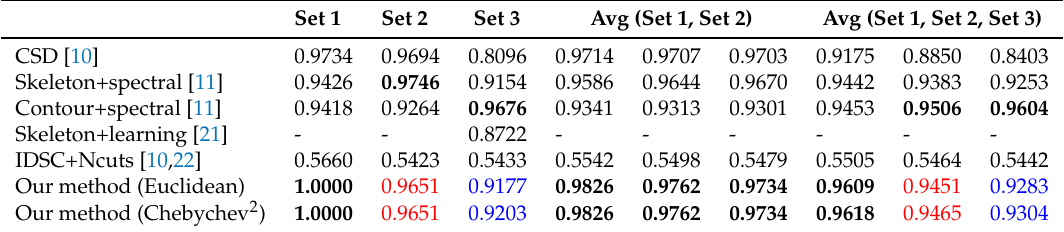
Table 3. Comparison of our clustering results with the state of the art methods using NMI. The best scores are marked as bold. Red and blue colors in the last two rows indicate a clustering result of which NMI is 99% and 95% of the best